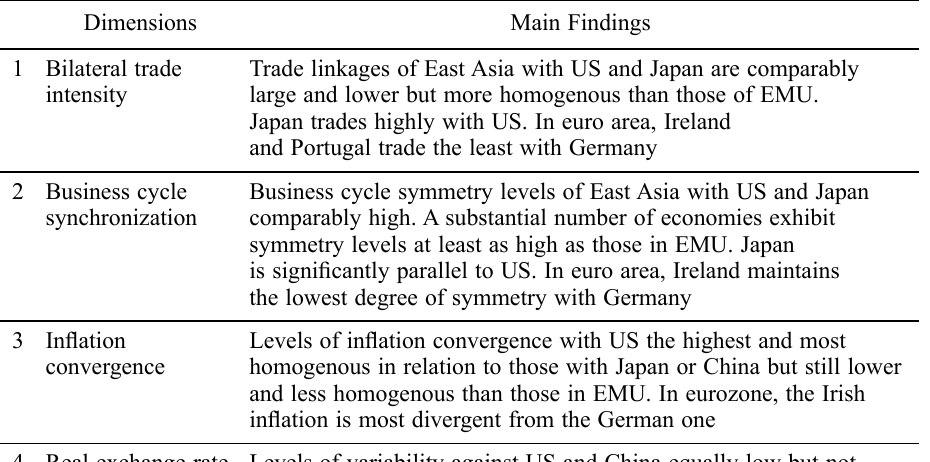
Table 3. Summary of